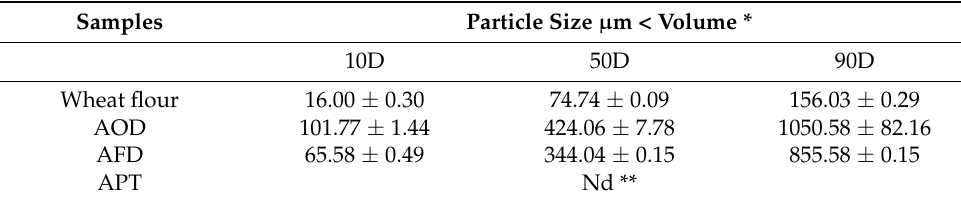
Table 1. Particle size distribution of wheat flour, oven-dried and freeze-dried flour of A. domesticus .